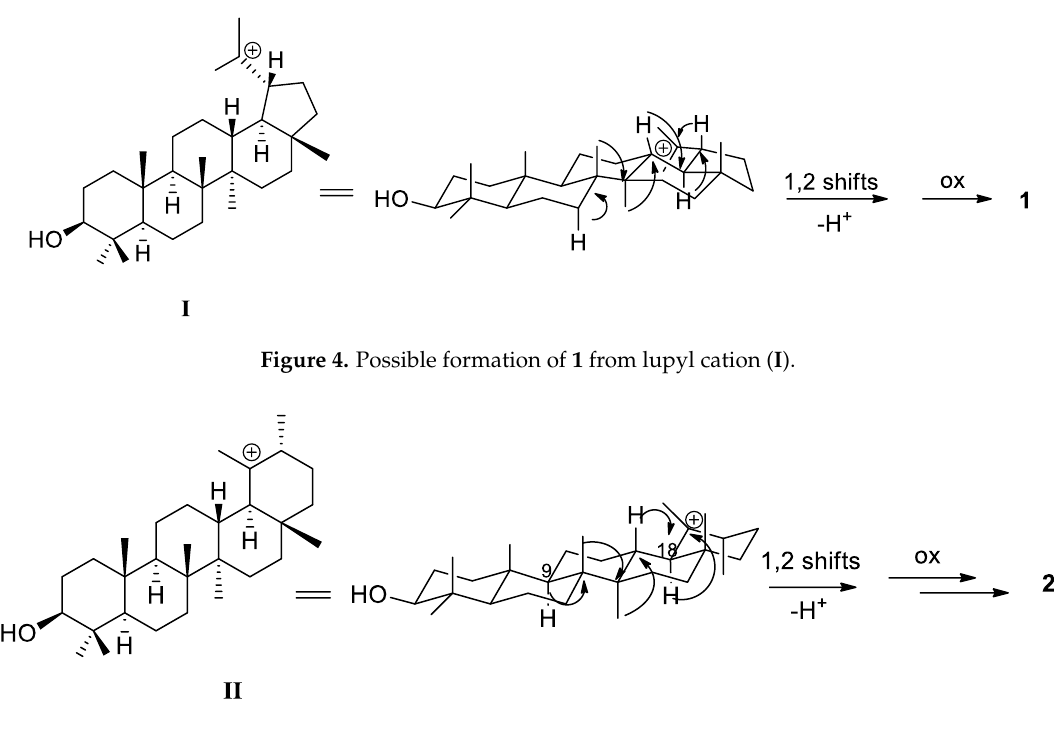
Figure 3. Selected NOE effects (red arrows) for compounds 1 ( a ); 2 ( b ); and 3 ( c ).